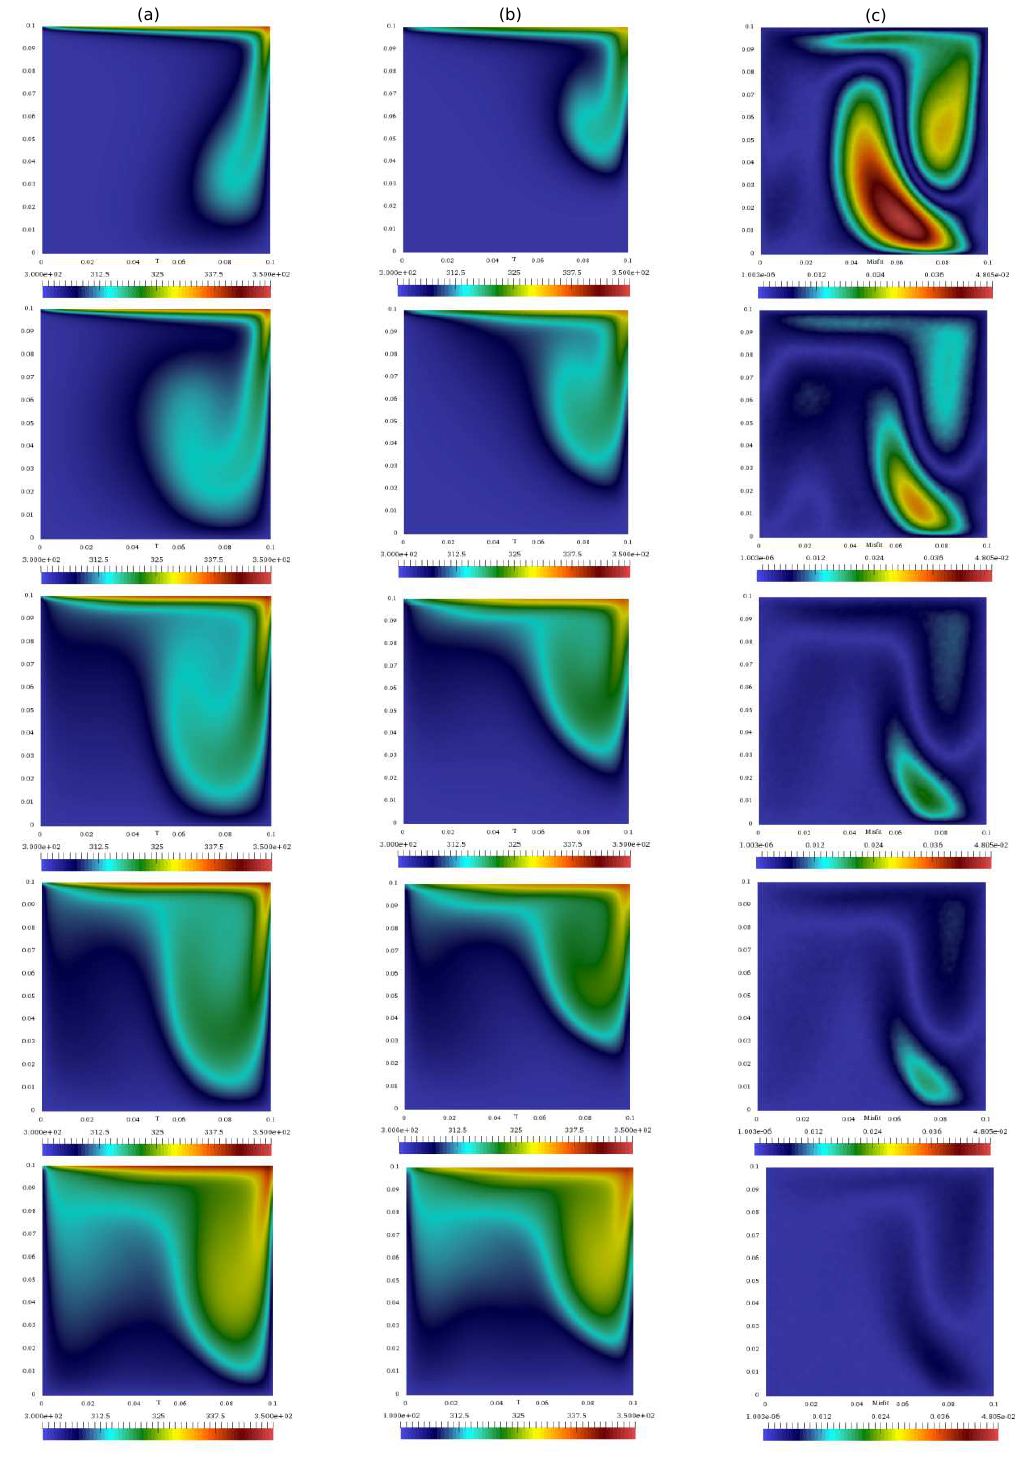
Figure 12. Temperature profile within the domain of: the coupled algorithm with Kalman filter ( a ); the standard PISO algorithm ( b ); and the difference between the time solutions of the filter and of the standard algorithm computed on the finest mesh ( c